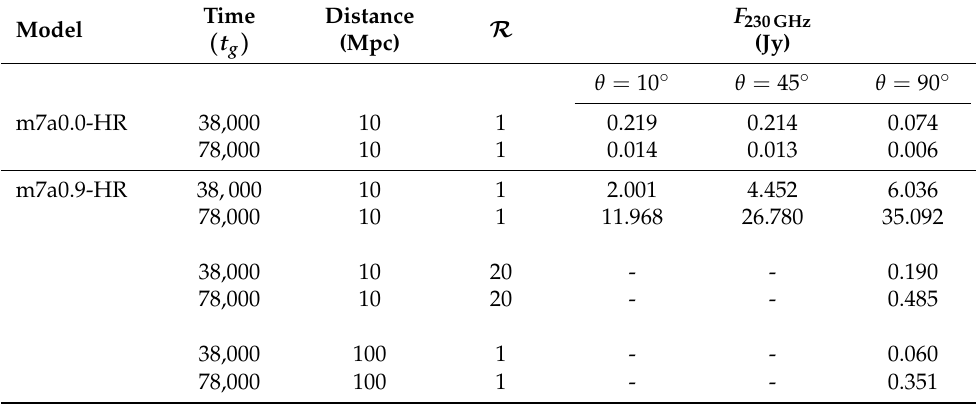
Table 2. Here we tabulate the 230 GHz flux density for each model given a specific time, viewing angle θ , distance D , and temperature ratio R